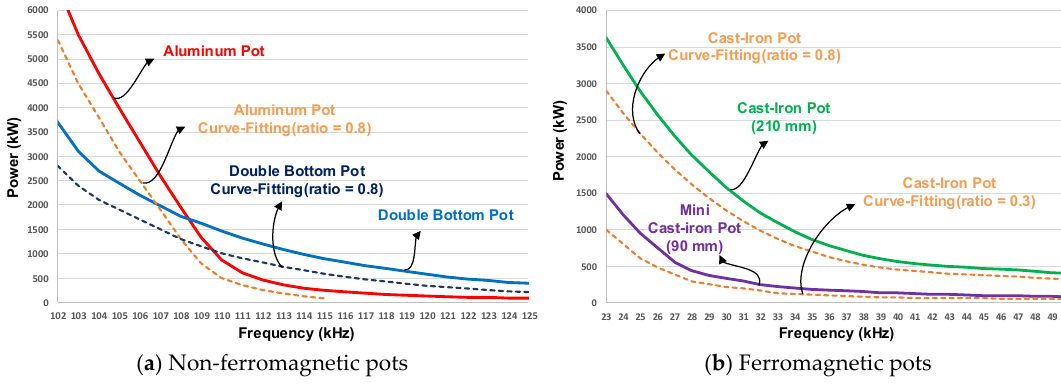
Figure 10. Power limit curve using curve-fitting method (CFM) modeling by pot-type.